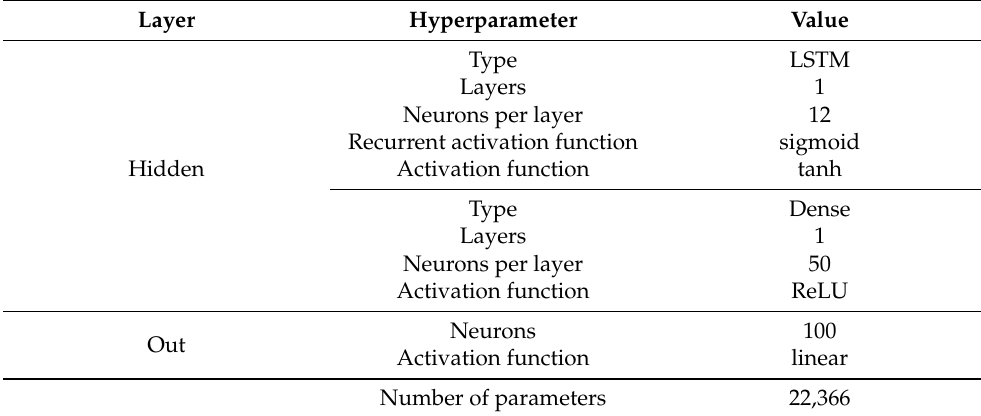
Table 8. Mayo’s architecture hyperparameters [25].